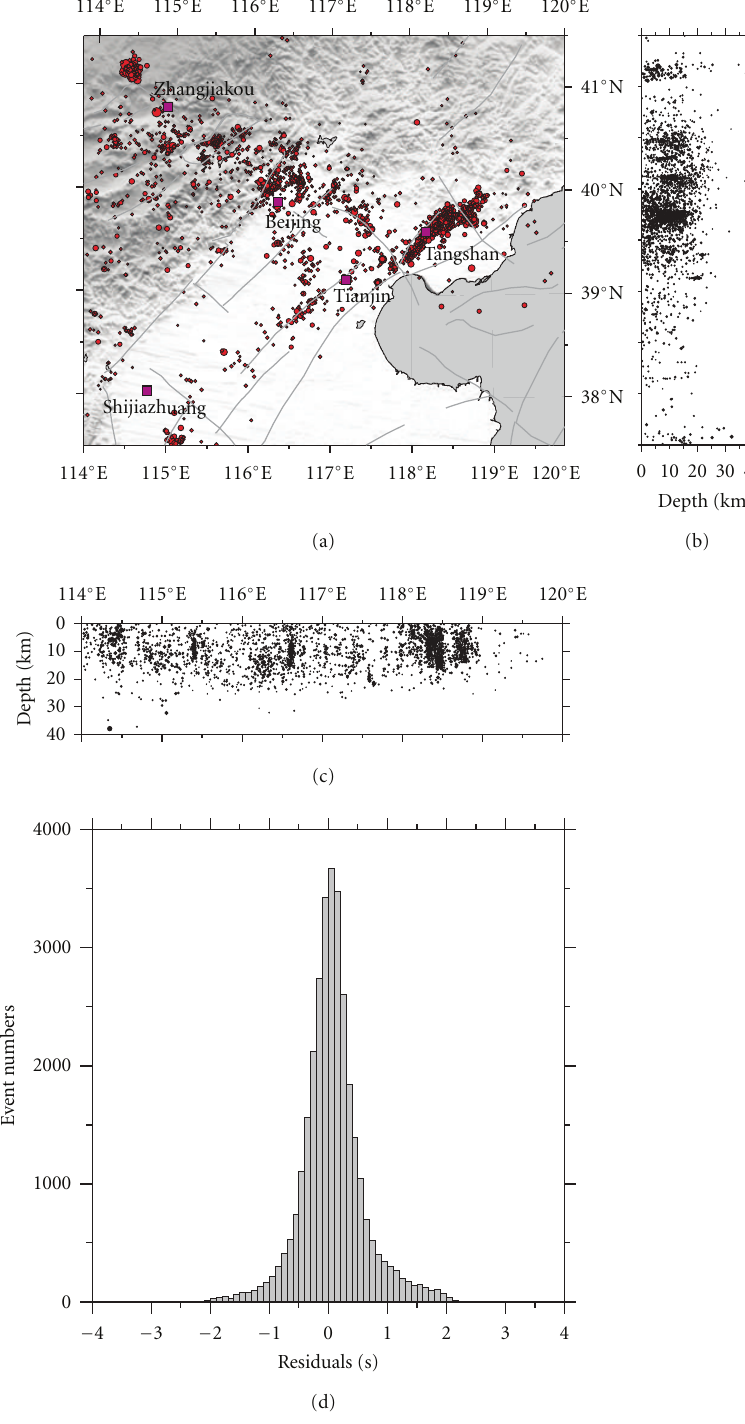
Figure 8: Earthquake hypocenters relocated in this study. (a) shows distribution of relocated earthquake epicenters (circles); squares show the major cities. Thick lines denote active faults; (b) and (c) show the cross-sectional view of focal depth along latitude and longitude profiles, respectively; (d) denotes histogram of P wave absolute travel-time residuals after relocation using tomoDD